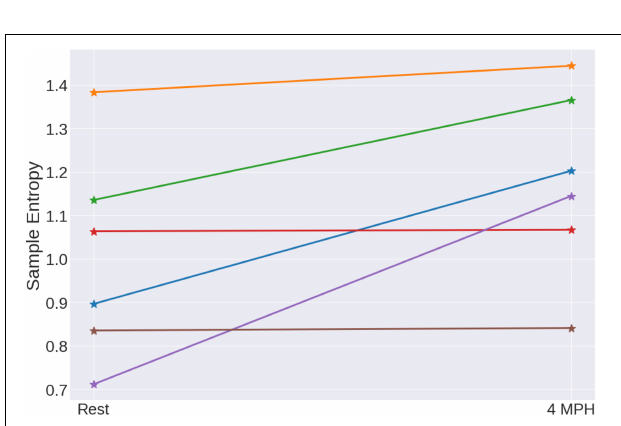
For this test, the slope of the line between the value of entropy at rest and the ST was compared for the two groups